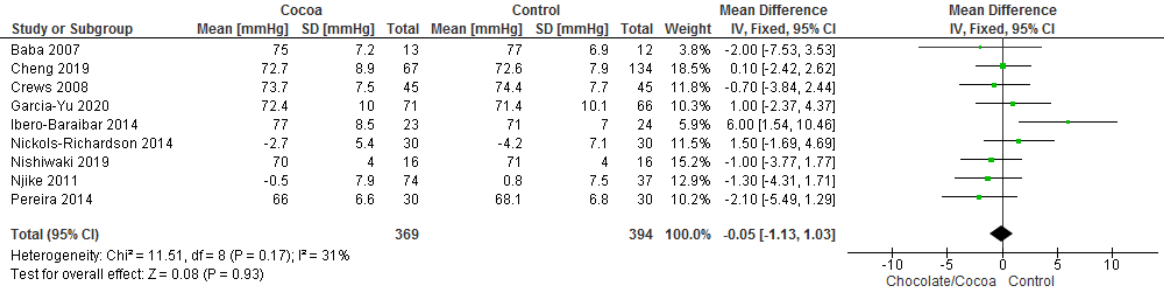
Figure 4. Forest plot of comparison: chocolate versus control, with the outcome - diastolic blood pressure (mmHg).